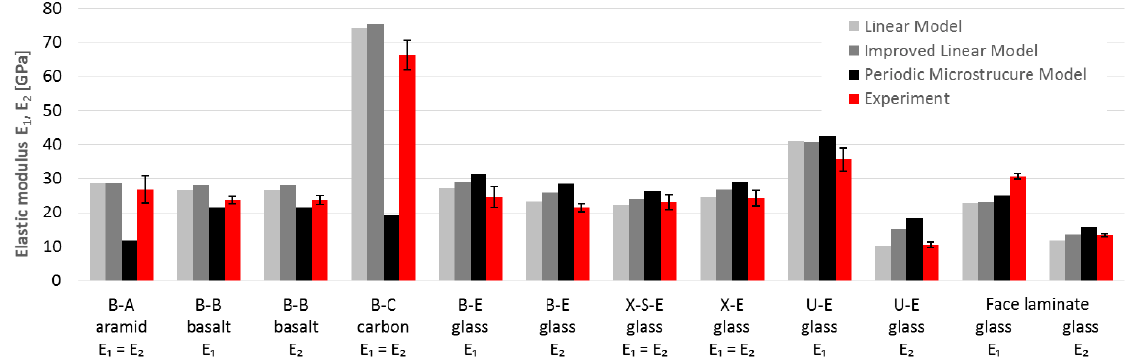
Figure 10. Comparison of elastic modulus E 1 and E 2 obtained by calculation and experiment.